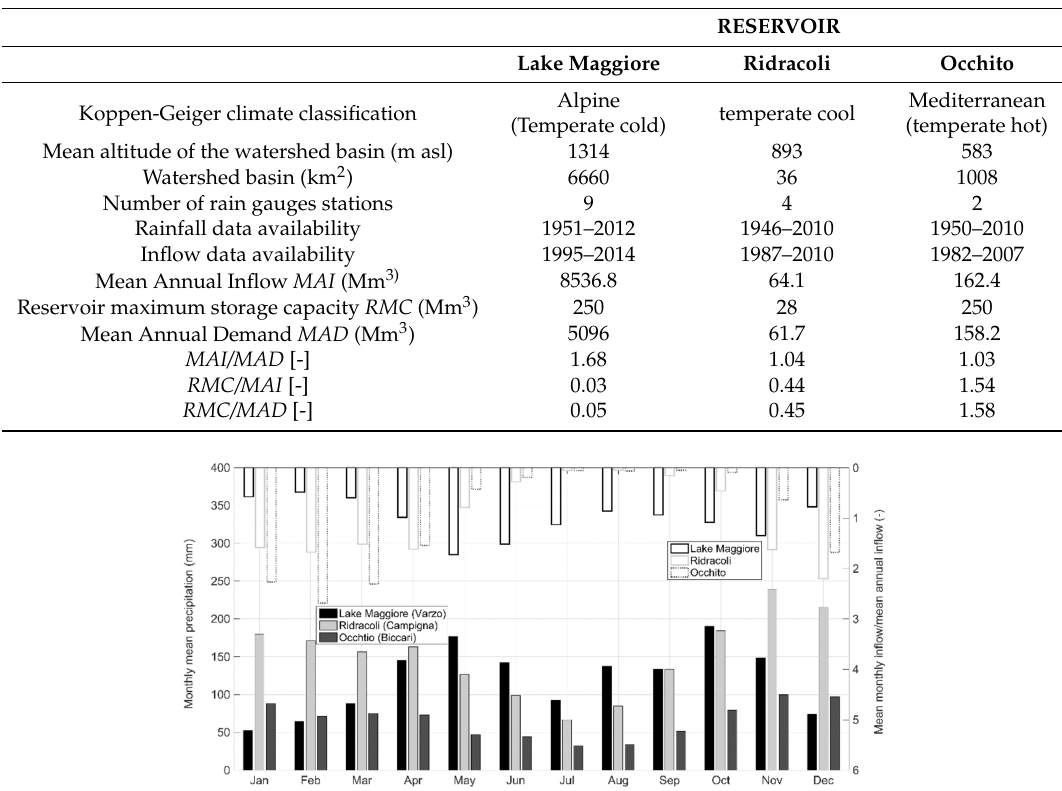
Table 1. Main characteristics of the three case studies.